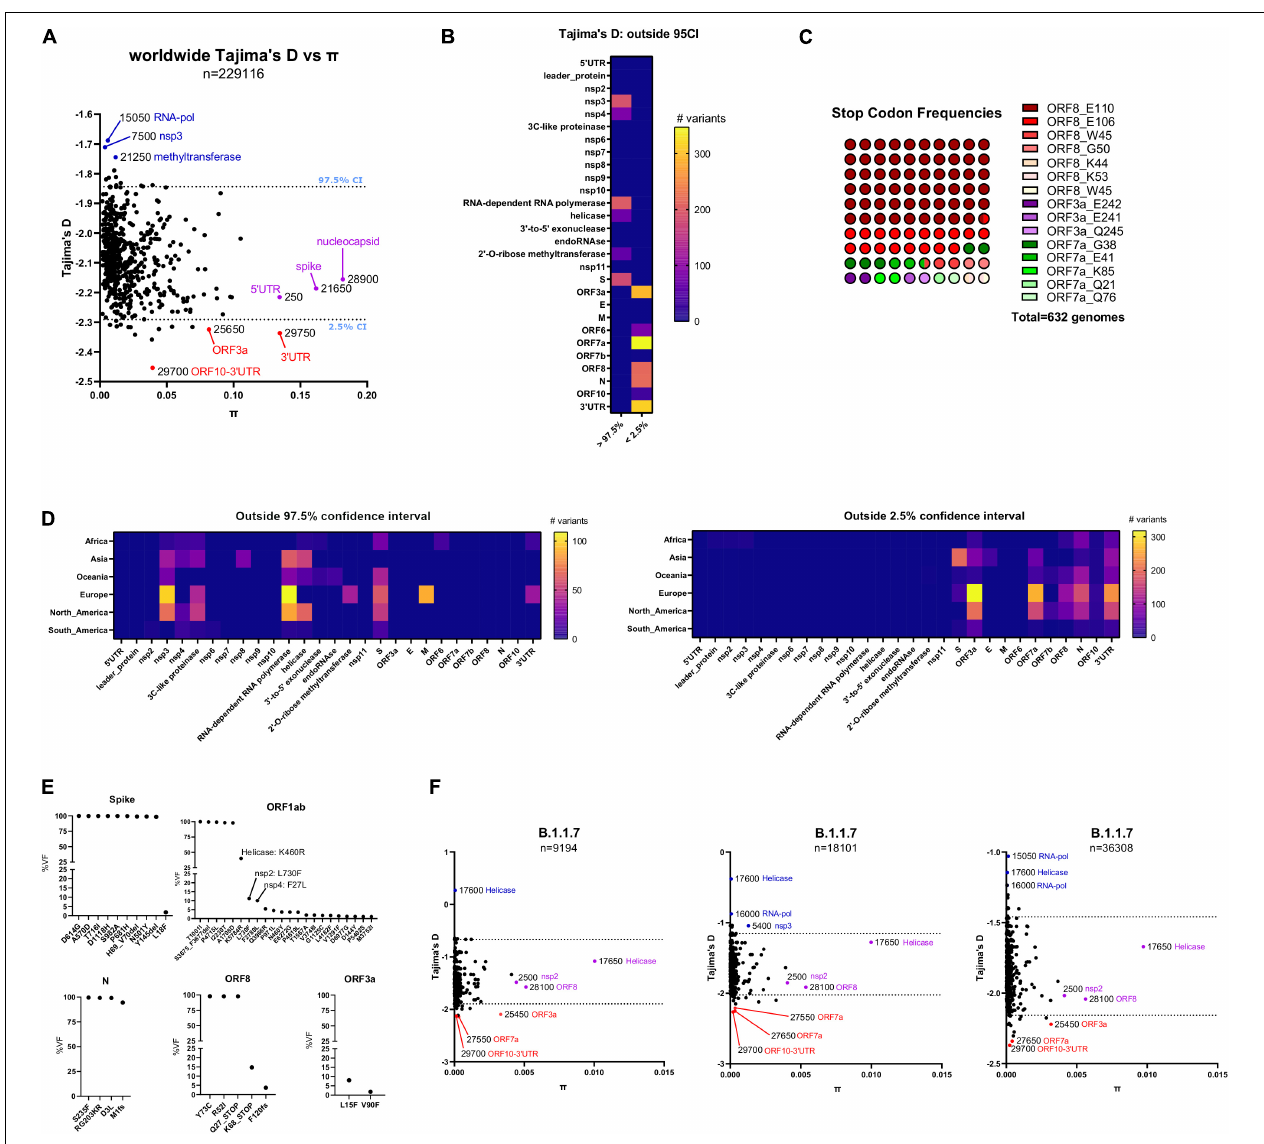
FIGURE 3 | (A) Worldwide distribution of Tajima’s D values versus nucleotide diversity ( π ) for 595 bins of 50 bp in length derived from 229,124 GISAID genomes. The dashed lines correspond to the upper (97.5%) and lower (2.5%) percentiles of the empirical distribution of Tajima’s D for each bin. Genes containing the top three most extreme outlier bins are depicted in blue (in the upper 97.5th percentile) and red (in the lower 2.5th percentile). Also, genes containing the top three most diverse bins are depicted in purple. (B) Number of variants per gene derived from bins in the 97.5th and 2.5th percentile of the empirical distribution of Tajima’s D values from A, respectively. (C) Parts-of-whole plot of non-sense (Stop Codon) frequencies with worldwide viral frequencies over or equal to 1% from 229,124 GISAID genomes until November 30, 2020. ORF8 stop codons are depicted in a range of red colors, ORF3a stop codons are depicted with a range of purple colors, and ORF7a stop codons are depicted with a range of green colors. (D) Variants per gene derived from bins in the 2.5th and 97.5th percentile of the empirical distribution of Tajima’s D values, derived from African ( n = 4301), Asian ( n = 11,986), Oceanic ( n = 17,211), North American ( n = 47,658), South American ( n = 2325), and European ( n = 145,884). GISAID genomes, respectively. (Left) Plot of genes containing bins in the 97.5th percentile of the empirical distribution of Tajima’s D from GISAID genomes in every geographical region, until November 30, 2020. (Right) Plot of genes containing bins in the 2.5th percentile of the empirical distribution of Tajima’s D from GISAID genomes in every geographical region, until November 30, 2020. (E) Viral frequencies (as percentages) arranged per gene from variants contained in the VOC genomes submitted in GISAID until January 17th, 2021. (F) Same plot as (A) for GISAID genomes from the B.1.1.7 lineage submitted in GISAID until January 07, 2021 (left, 9194 genomes), January 17, 2021 (middle, 18,101 genomes), and January 27, 2020 (right, 36,308 genomes).